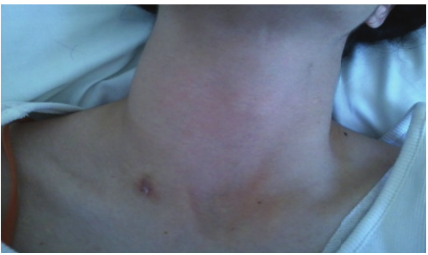
Figure 1: Patient’s neck showing tenderness, redness and edema.